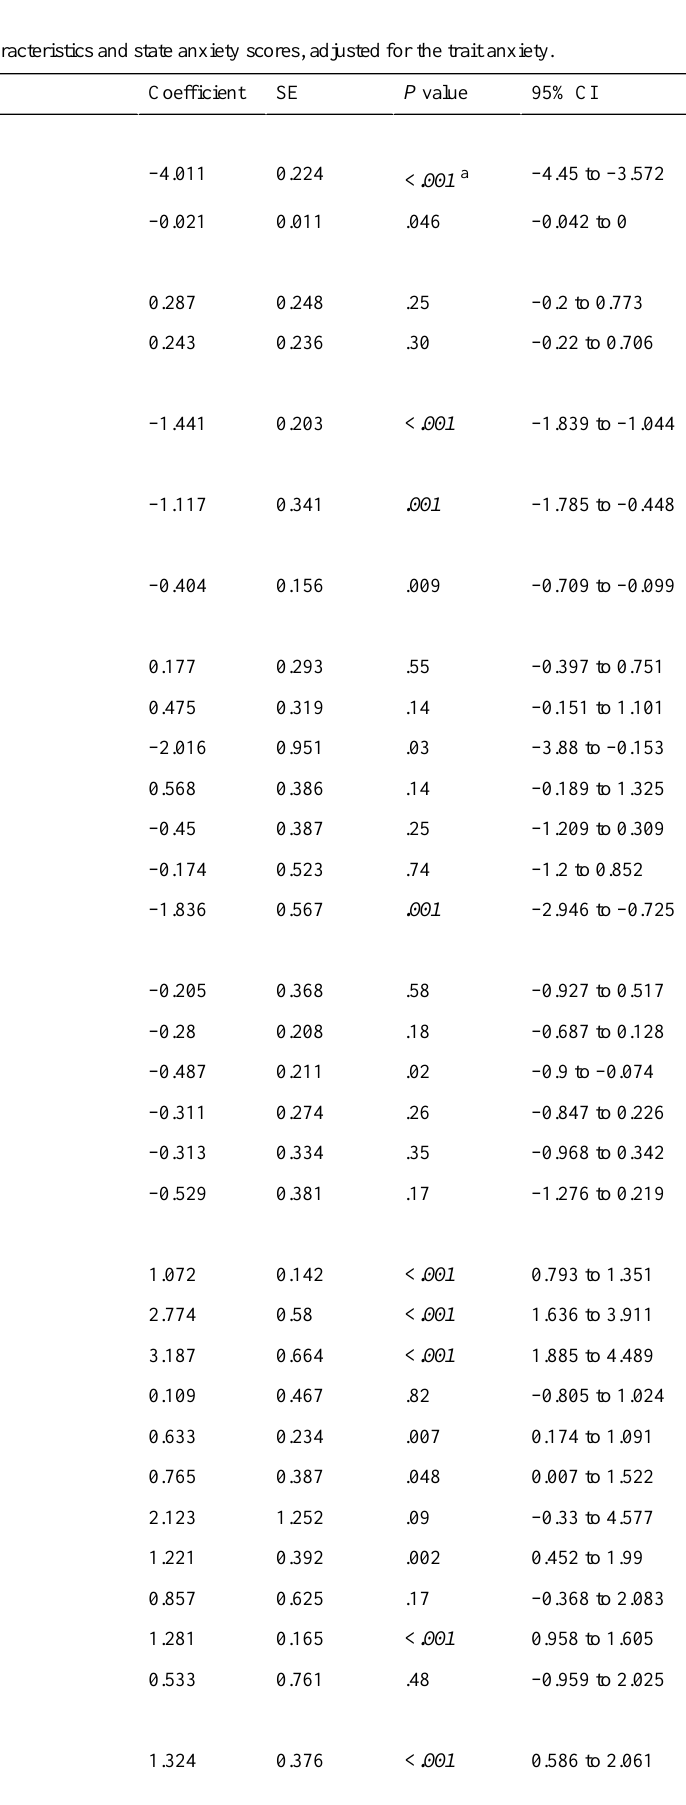
Table 2. Regression model assessing associations between characteristics and state anxiety scores, adjusted for the trait